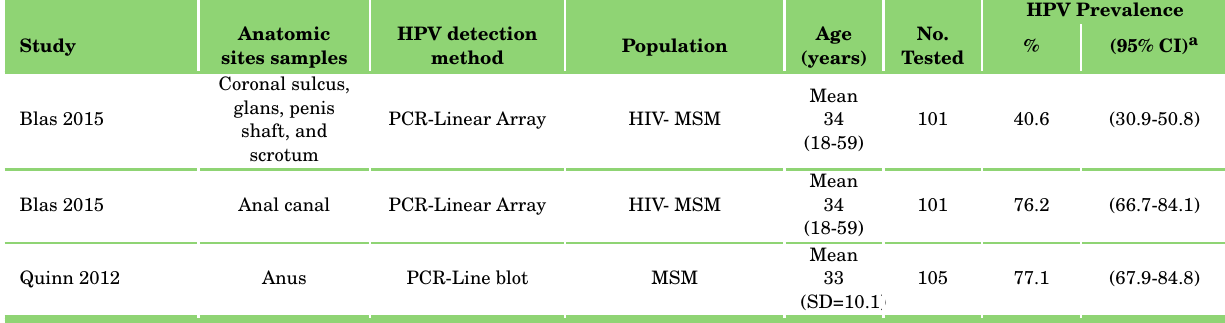
Table 34: Studies on HPV prevalence among men from special subgroups in